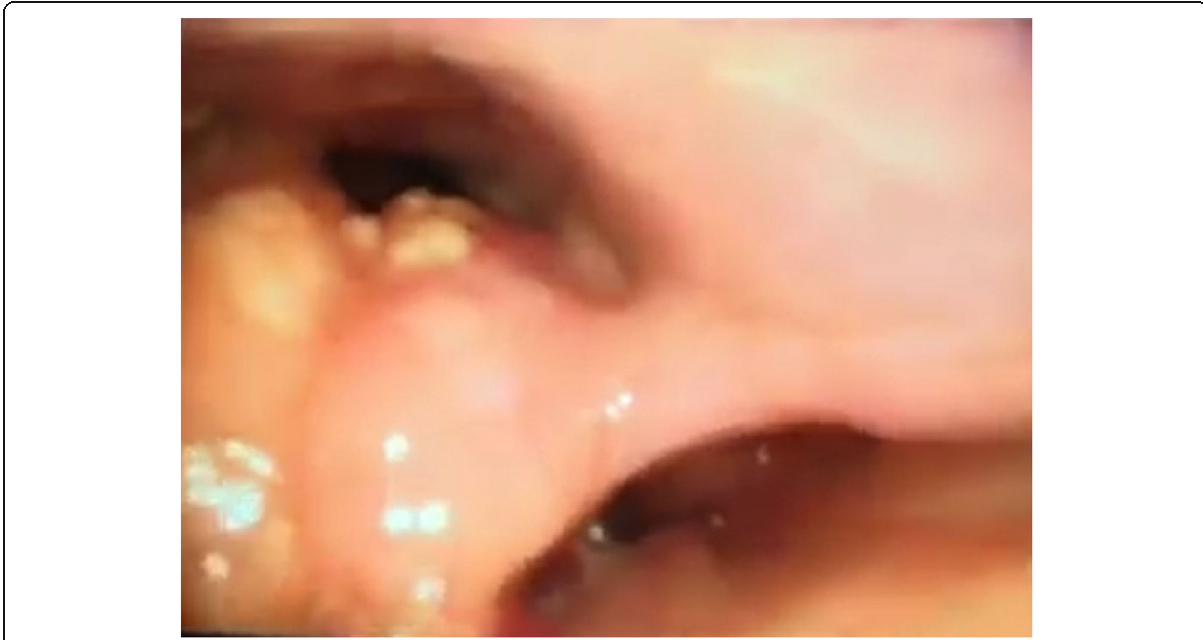
Fig. 4 Peri-laryngeal edema with true vocal cords not